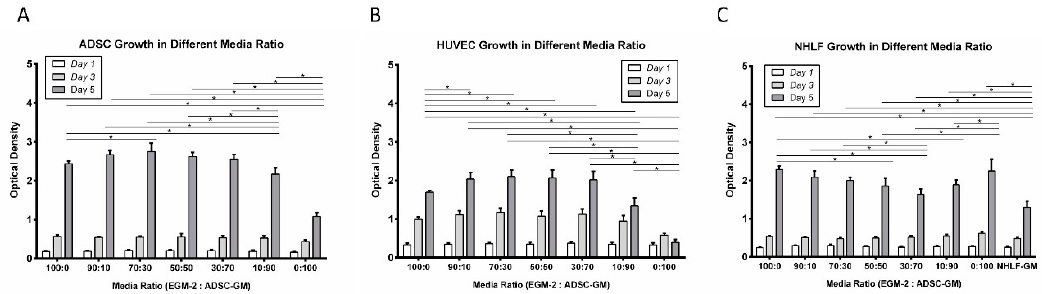
Figure 2. Influence of media composition on cell proliferation. ( A ) ADSC, ( B ) HUVEC, and ( C ) NHLF proliferation in different EGM-2: ADSC-GM media ratios. For all datasets, the values are means ± SD, n = 6. One-way ANOVA followed by Tukey’s multiple comparisons test was performed. *Denotes significant difference ( p < 0.05) between groups.